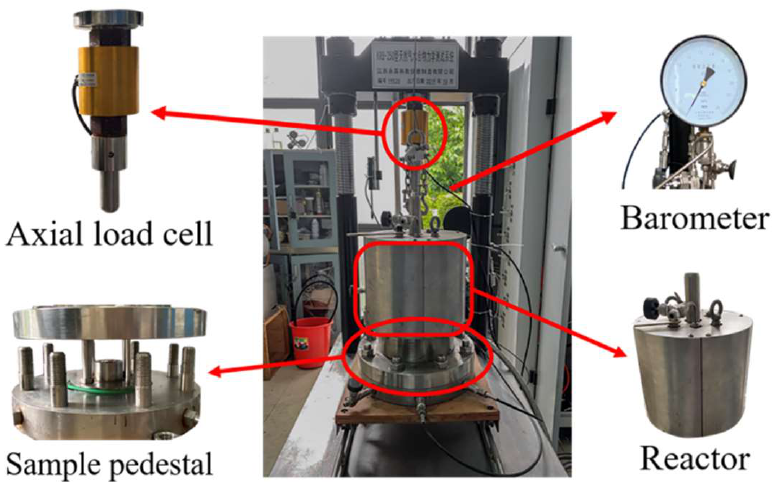
Figure 2. Appearance of triaxial test system.